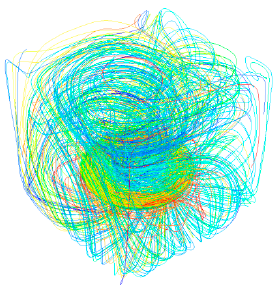
Figure 1. Flow in a cylindrical vessel with radial agitator with curved blades: ( a ) vessel without baffles; ( b ) vessel with four radial baffles.